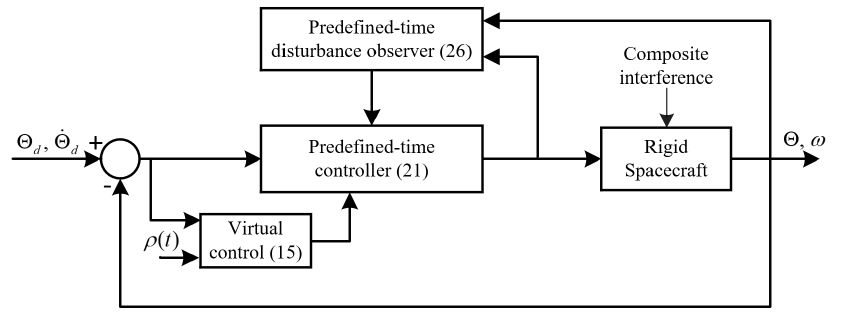
Figure 3. The block diagram of the proposed observer-based attitude tracking control